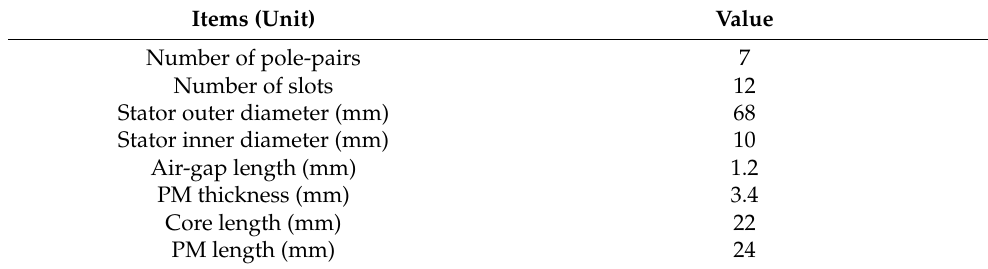
Table 1. Main parameters of the PM motor.